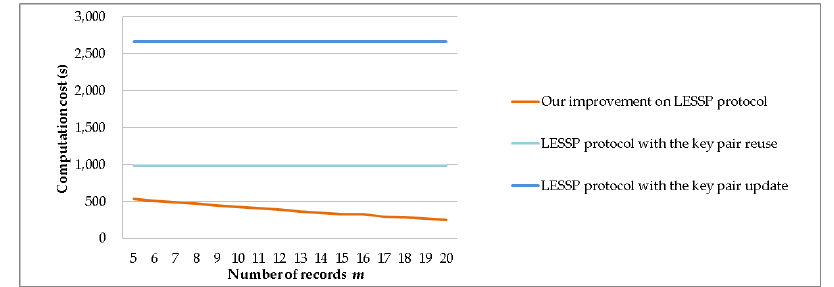
Figure 14. The computation time costs against the number of records m .